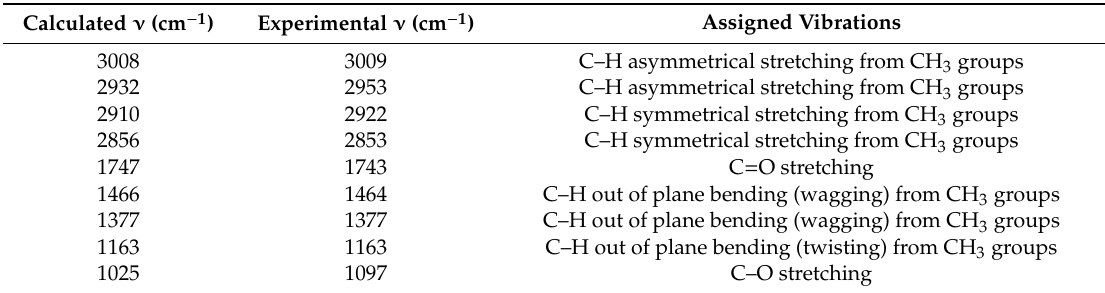
Table 2. Experimental vibrational frequencies for oily vitamin A and the calculated vibration frequencies for vitamin A.